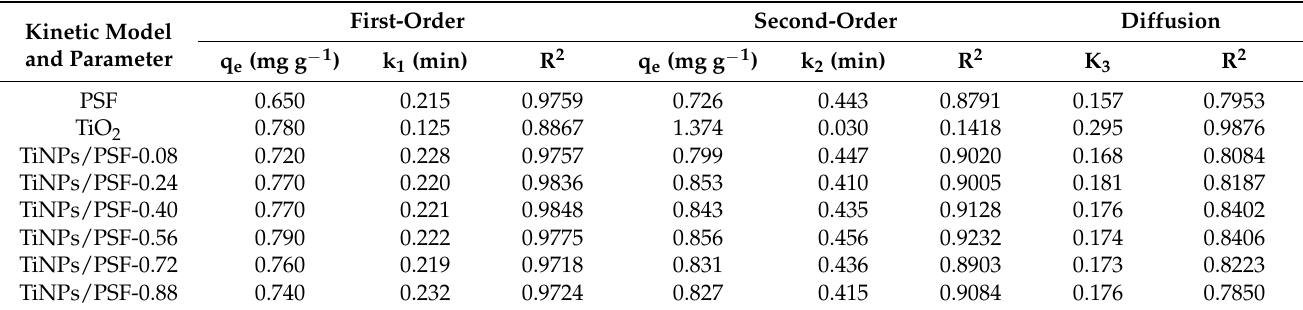
Table 2. The adsorption kinetic parameters of methyl blue (MB) on TiNPs/PSF composite microspheres. Kinetic